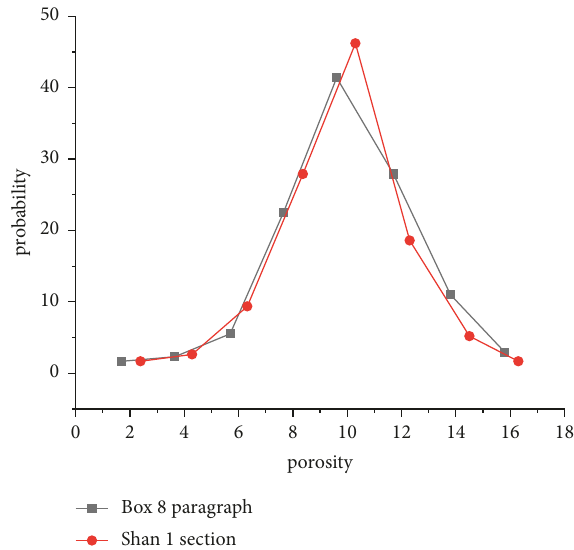
Figure 1: Distribution characteristics of reservoir porosity in the study area.